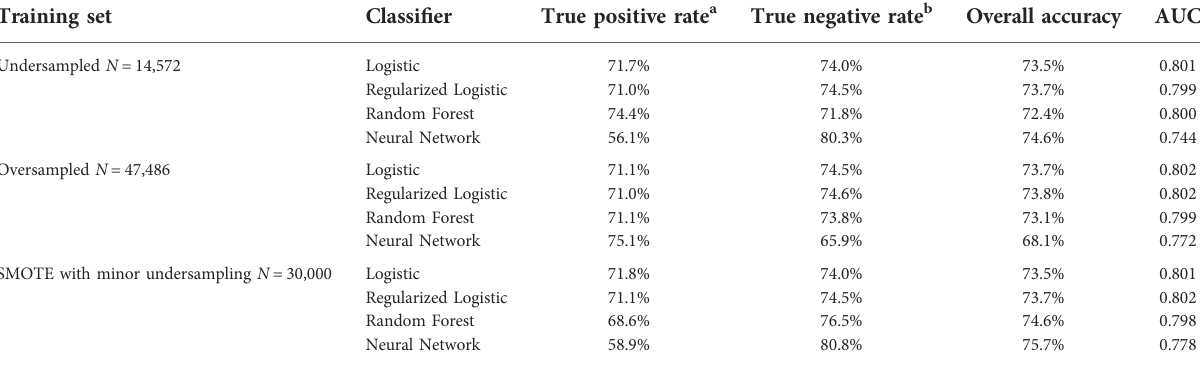
TABLE 3 Model performance on test set by training set type. Training